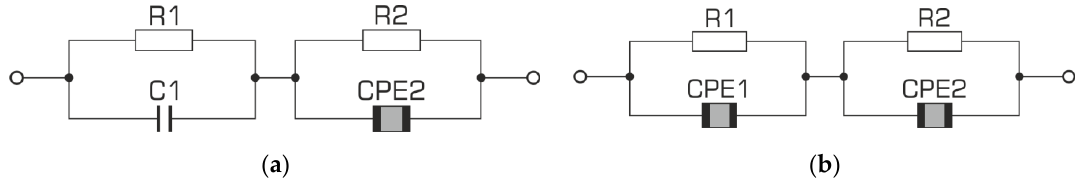
Figure 9. RC electric equivalent systems with fixed constant-phase elements CPE: With single element CPE ( a ) and with double element CPE ( b ).